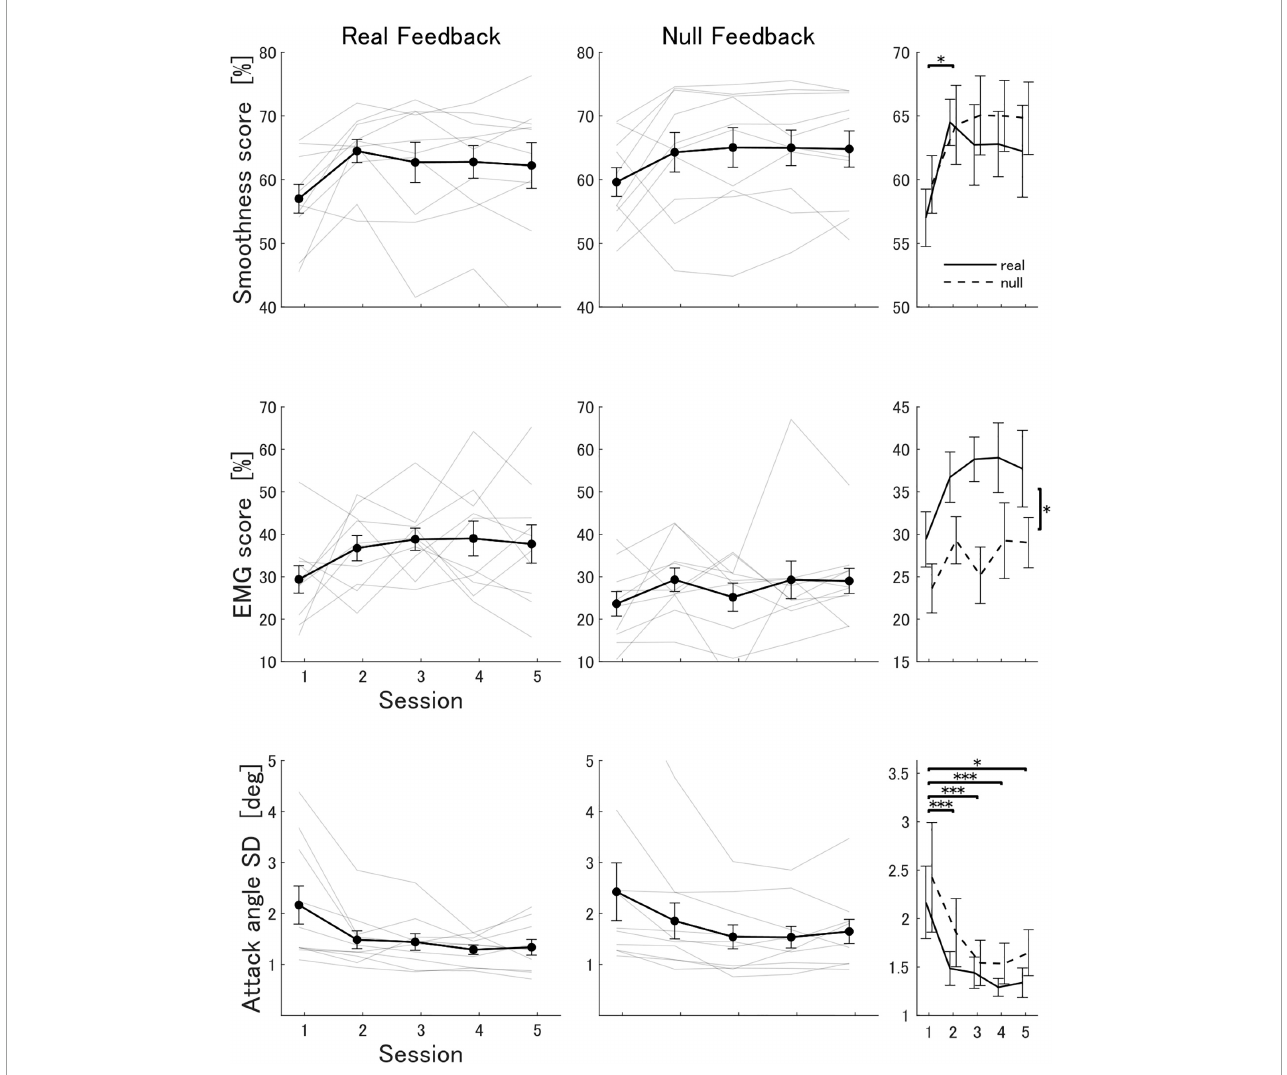
FIGURE3 Progression of the smoothness score, EMG similarity score and attack angle variability in the real and null feedback groups. The attack angle variability was measured as the standard deviation of the attack angle across all trials in one session. Thick lines indicate the mean score across participants in each group. Light lines indicate scores for each participant. Error bars indicate the standard error. The third column summarizes statistical comparisons. Asterisks indicate significant differences between metrics: ∗∗∗ p < 0.001, ∗ p <